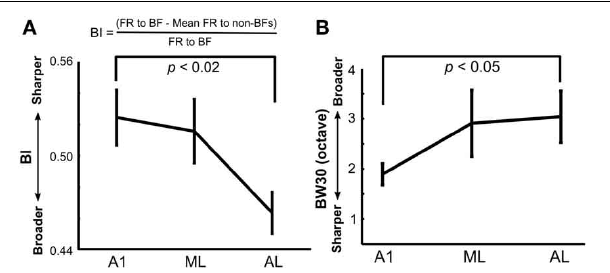
FIGURE 4 | Tuning width in A1, ML, and AL measured using (A) a bandwidth index (BI) and (B) a traditional BW30 index. BI was calculated based on the formula shown using the fine-tuning paradigm (see Methods). There was a main effect of recording site on BI (Kruskal-Wallis test: p < 0 . 02) with significantly sharper tuning in A1 compared to that in AL (Tukey’s HSD test, p < 0 . 01). Tuning width using BW30 gave similar results with significantly sharper tuning in A1 than AL ( p < 0 . 05, Wilcoxon rank sum test). Means are plotted and standard errors are represented